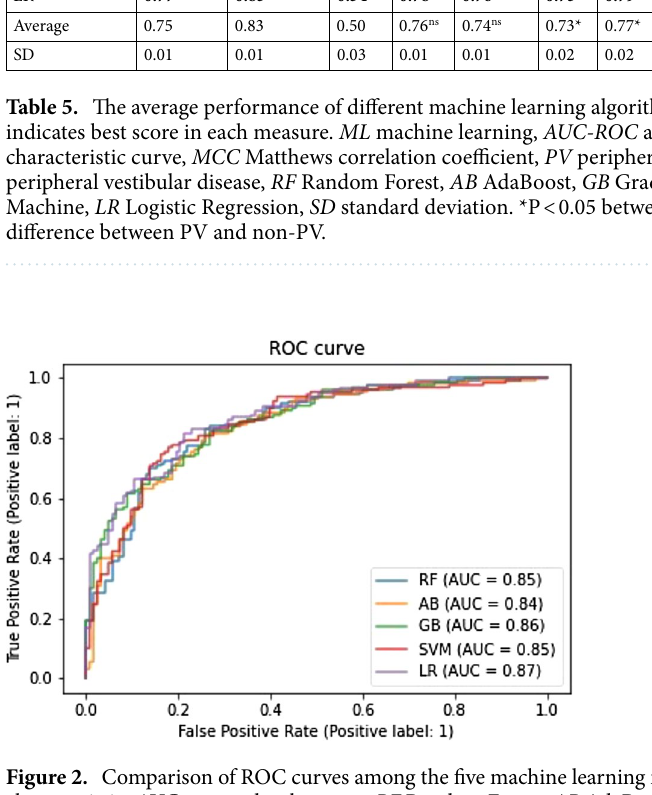
Figure 2. Comparison of ROC curves among the five machine learning models. ROC receiver operating characteristic, AUC area under the curve, RF Random Forest, AB AdaBoost, GB Gradient Boosting, SVM Support Vector Machine, LR Logistic